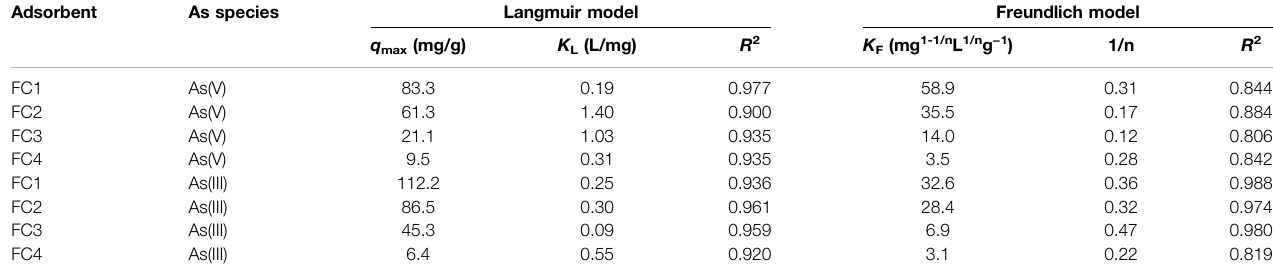
TABLE 2 | Langmuir and Freundlich isotherm parameters for As (V) and As (III) adsorption on Fe-Cu binary oxides at pH 7.0 ± 0.1. Adsorbent As species